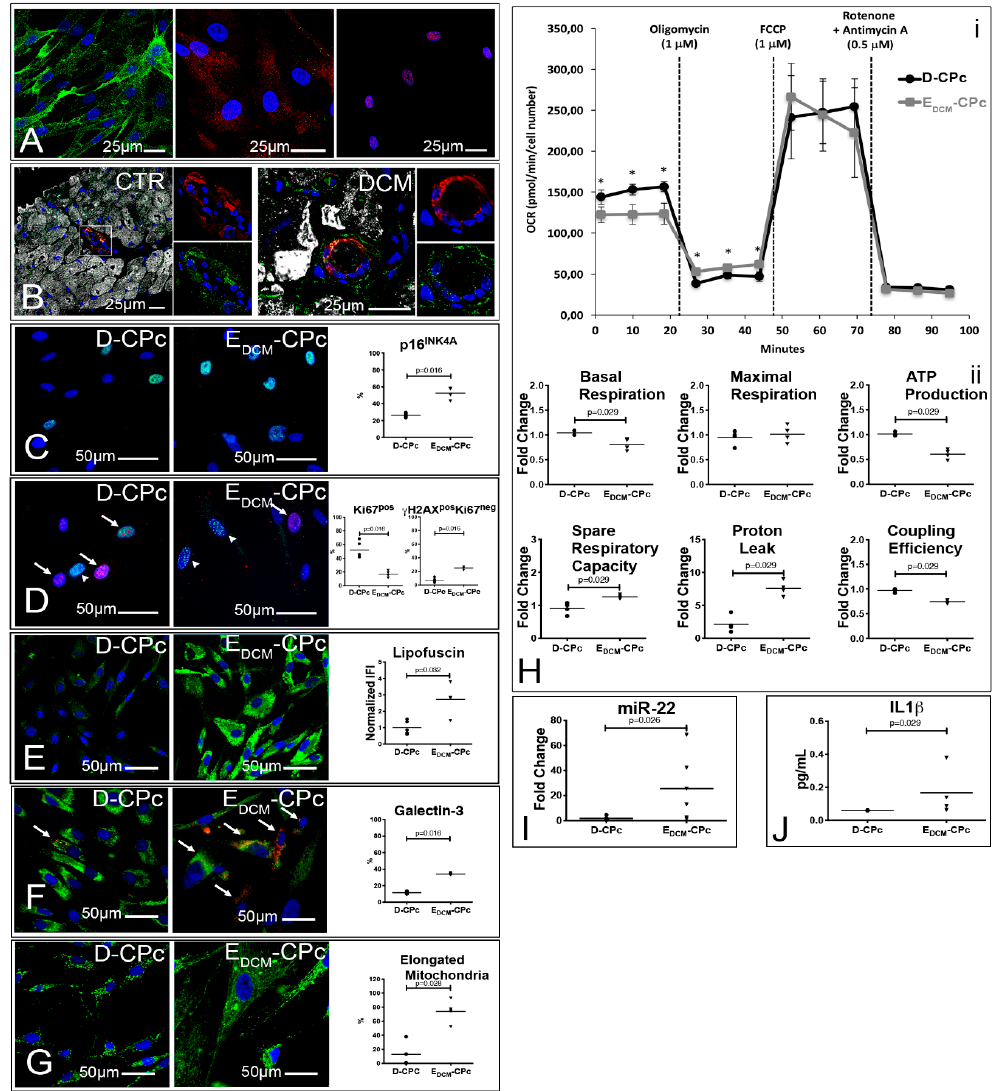
Figure 5. Cardiac pericytes isolated from diseased hearts are senescent and accumulate dysfunctional mitochondria. ( A , B ) In vitro and in vivo characterizations of CPc. Confocal images of cultured CPc ( n = 5 D-CPc and n = 5 E DCM -CPc) stained for NG2 (green, left panel), PDGFR α and PDGFR β (green and red, central panel), and Tbx18 (red, right panel; ( A) ). Confocal images showing that mostly PDGFR β + cells (green) are localized in and around arterioles and capillaries and coexpress smooth muscle actin (red). ASA is shown in white ( B ). ( C – G ) Senescence and ALP dysfunction of E DCM -CPc. Epifluorescence images of CPc isolated from normal (D-CPc; n = 5) and pathologic hearts (E DCM -CPc; n = 4) show positivity to p16 INK4A (green, C), γ H2A.X (green) and Ki67 (red, D ), lipofuscins (green, €), Galectin 3 (red) and LAMP2 (green, ( F) ), and mitochondria (green, ( G) ). Nuclei are labeled by DAPI in blue. Dot plots in C–G indicate the results of the quantitative analysis; Mann–Whitney tests were employed. (H) Profiles of mitochondria bioenergetics measurements. Plots in (i) display average ( ± S.D.) OCR of 4 D- and 4 E DCM -CPc, measured at baseline and after the addition of the stressors oligomycin, FCCP, rotenone, and antimycin A. Time and type of stressor administration are indicated by dashed lines. Parameters quantified from the experiment were normalized employing the respective average value of D-CPc and are shown in dot plots in (ii); Mann–Whitney tests were employed. ( I , J ) Real-time PCR and ELISA analyses of CPc. Results of RT-PCR analysis of miR22 expression in 6 D- and 6 E DCM -CPc ( I ). IL1 β concentration in CPc culture supernatant ( J ); Mann–Whitney tests were employed.